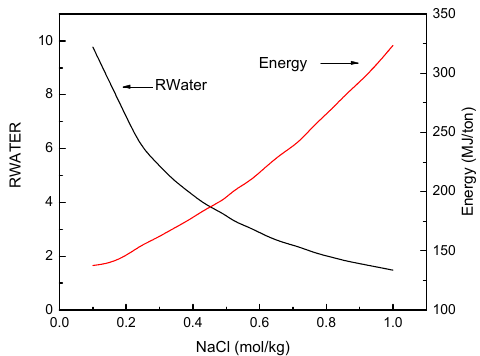
Figure 7. The effect of feed solution concentration on the FO process performance using Na 2 SO 4 as the draw solute.